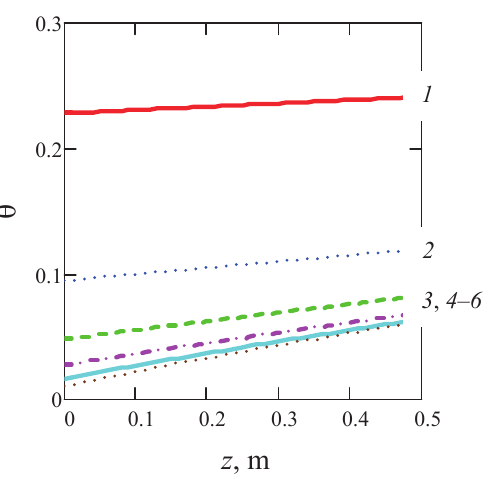
Figure 4 Relation between the radius mean specific